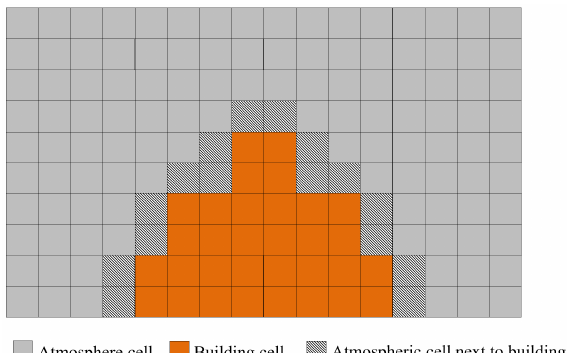
Figure 3. Masking concept in